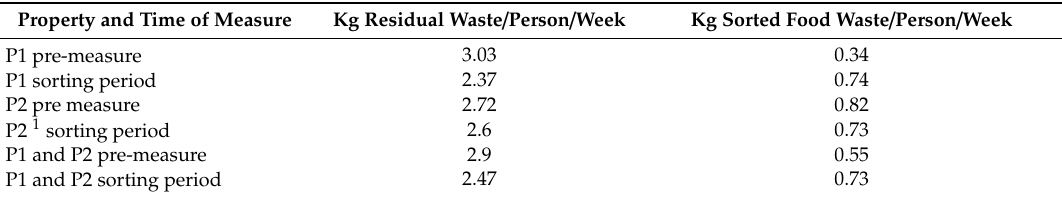
Table 1. The average amount (kg) of residual waste and sorted food waste per person and week calculated from the pre-measure and the sorting period in Property one (P1) and Property two (P2). Property and Time of Measure Kg Residual Waste / Person / Week Kg Sorted Food Waste / Person /